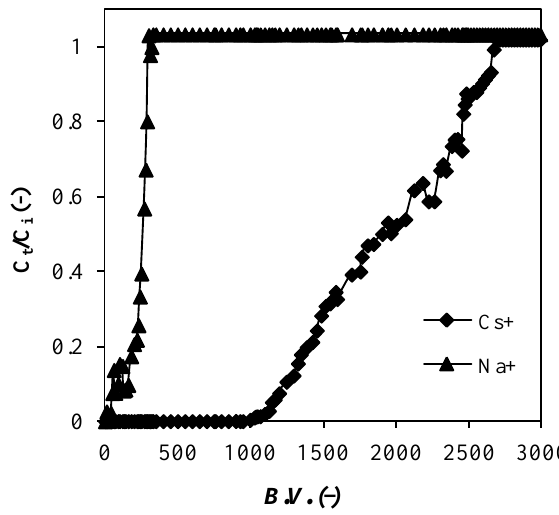
Figure 7. Breakthrough profiles of cesium(I) and sodium(I) ions from the column packed with CPT gel [17] (with permission for reuse from Elsevier